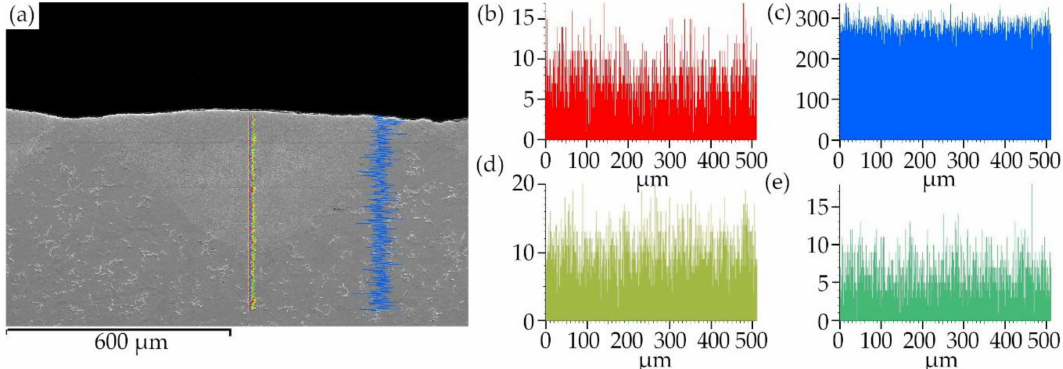
Figure 9. Line scan element analysis normal to the laser-processed surface: ( a ) place of line scan in cross-section of layer; ( b ) C distribution; ( c ) Fe distribution; ( d ) Si distribution; ( e ) Mn distribution. Table 8. Chemical compositions (by energy-dispersive X-ray spectroscopy analysis) of surface regions. Chemical Elements [wt.%] Region C Fe Si Mn Other Laser-processed area 1.49 97.28 0.20 0.42 0.61 Basic metal 1.13 97.67 0.21 0.43